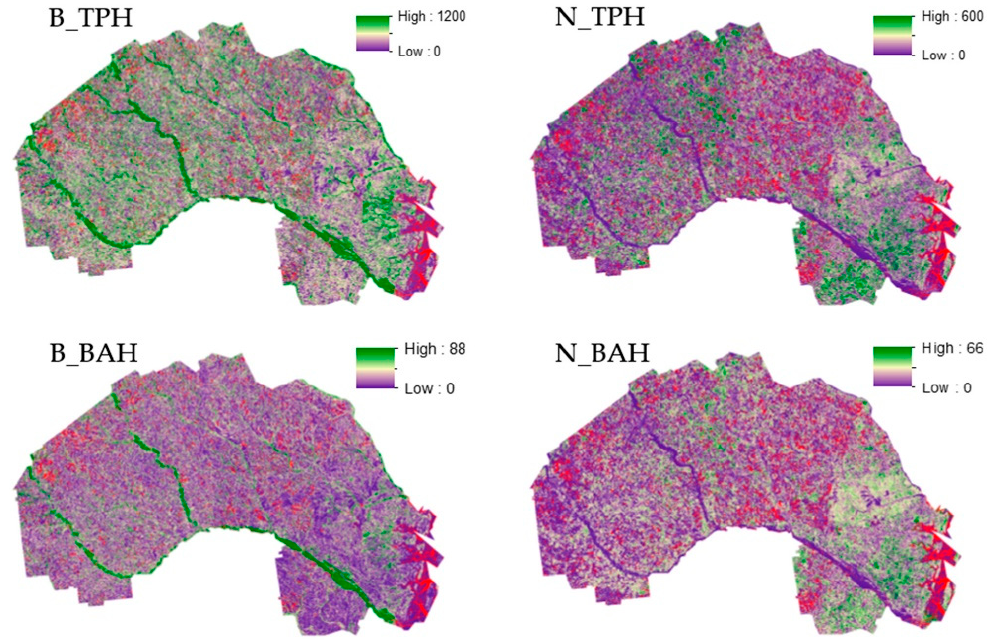
Figure A4. L2 Broad and needle-leaf TPH and BAH raster surfaces for the Fort Stewart SGA. Red areas within each graphic identify locations for which L2 models extrapolate estimates. Cell values for these areas are coded as NULL.